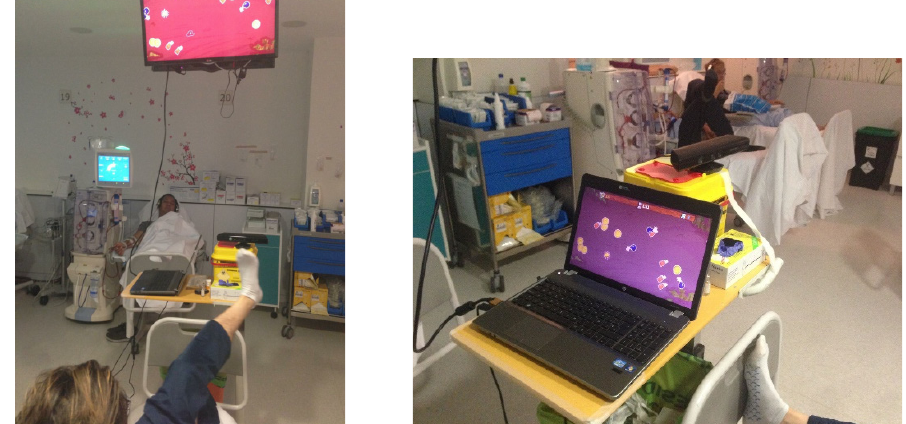
Figure 2. Intradialytic exercise with non-immersive VR (reproduced with permission from Segura- Ort í , E. et al., 2019)